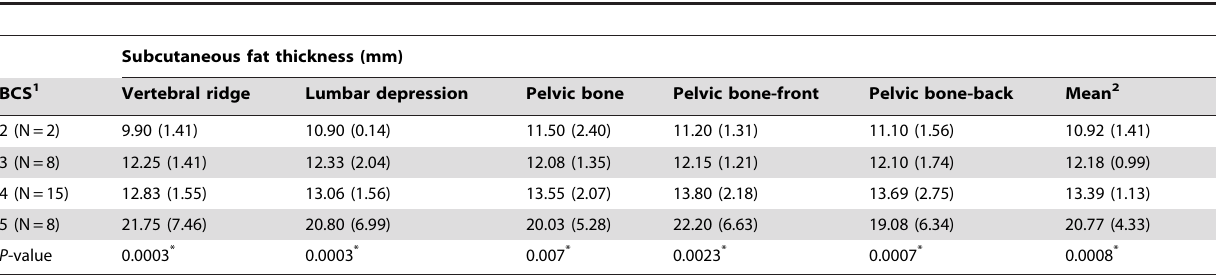
Table 1. Mean (SD) ultrasound measurements of subcutaneous fat thickness by body region and body condition score (BCS) category in zoo African elephants (N=